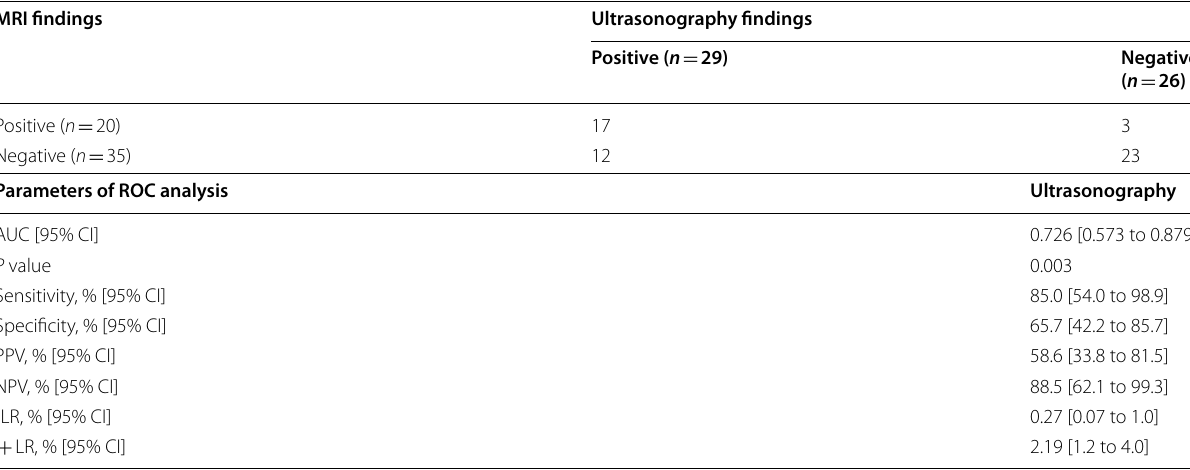
Table 2 Diagnostic value of ultrasound in the diagnosis of medial meniscus injury MRI findings